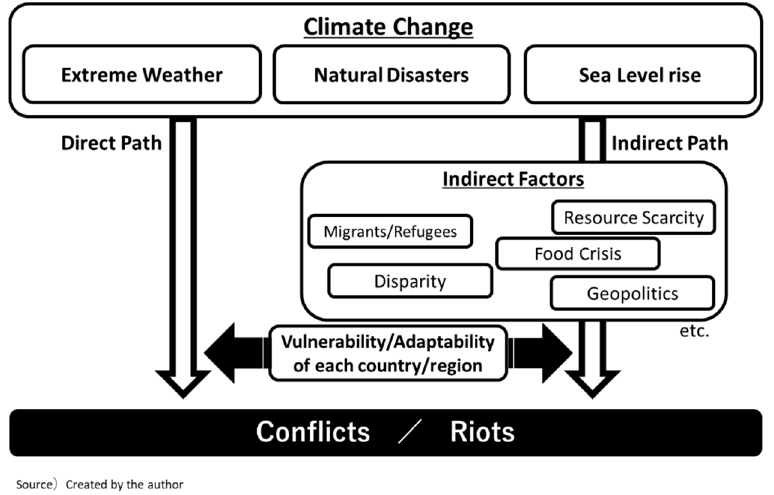
Figure 1. Pathways Connecting Climate Change with Conflict.